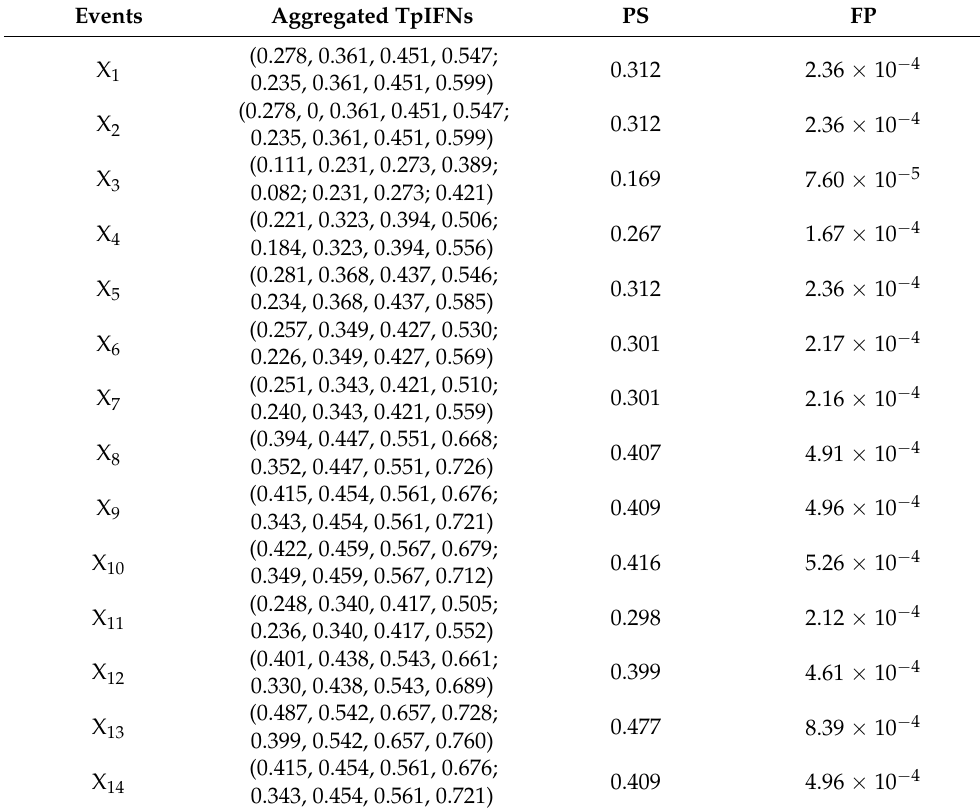
Table 15. The aggregated expert opinions and the corresponding failure probabilities of the root events in the